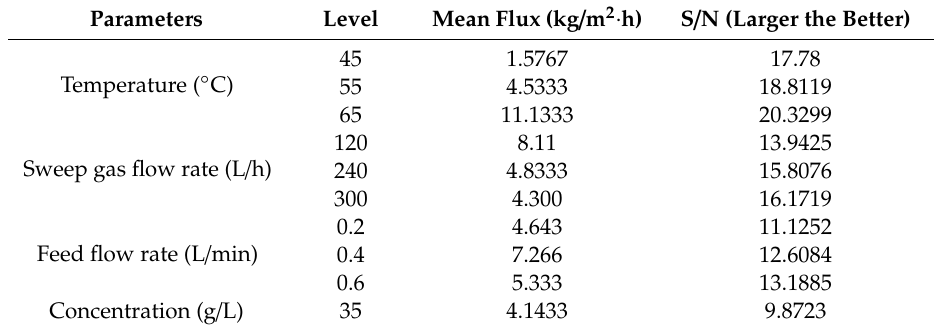
Table 8. Mean flux and S / N values at all levels of operating variables obtained from the Taguchi method.